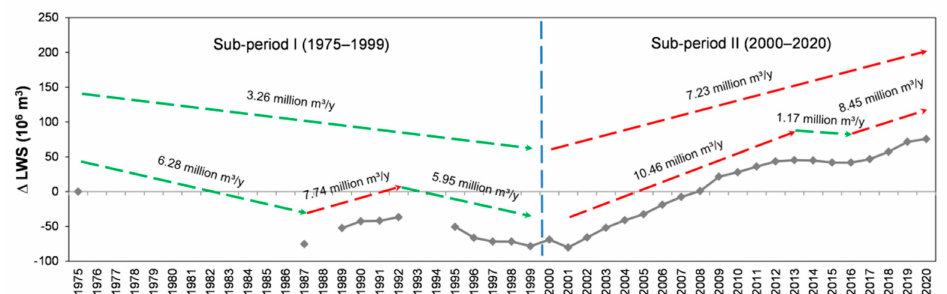
Figure 15. Final changes in the water storage of Gahai